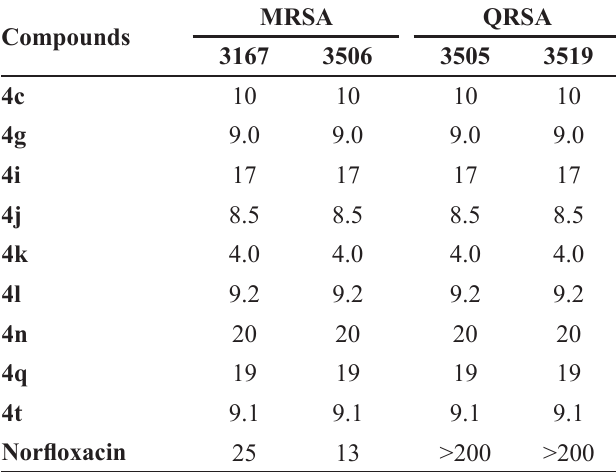
TABLE II - MIC values (in μM) against clinical isolates of multidrug-resistant Gram-positive bacterial strains